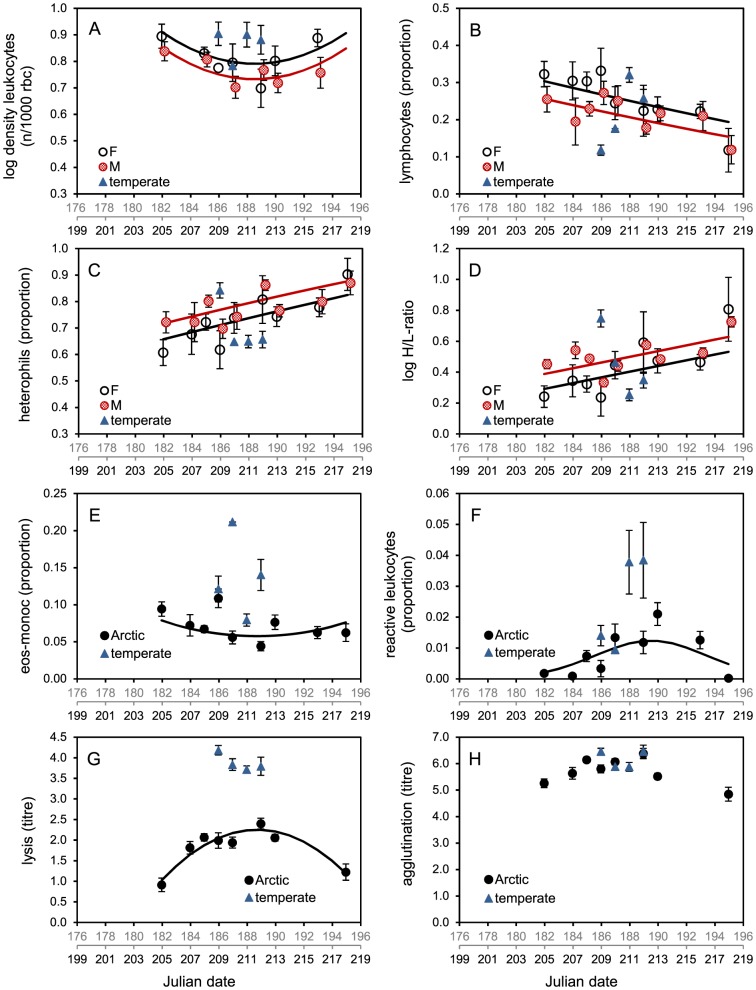
Measures of baseline immune activity (means ± SE) over time.Immune activity over the moulting season presented for each immune measure: (A) leukocyte density, (B) proportion lymphocytes, (C) proportion heterophils, (D) the H/L-ratio, (E) proportion eosinophils + monocytes (eos+monoc), (F) proportion reactive leukocytes, (G) lysis and (H) agglutination. The two x-axes show Julian dates (JD) from the average initiation of wing moult per population: the temperate population started at 176 JD (grey scale) and the Arctic population started at 199 JD (black). Males and females are displayed separately when sexes differed significantly (Table 2), otherwise means are for all birds. Trend-lines are based on the models in Table 2 (after back-transformation). The four catches in the temperate area (triangles) are too close in time to show seasonal effects.